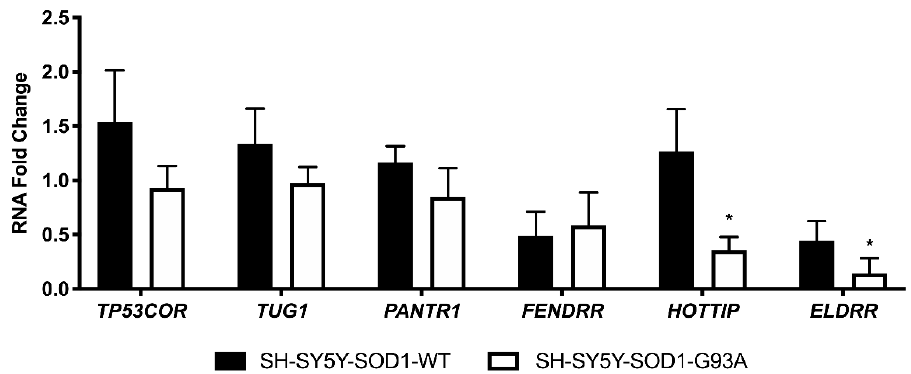
Figure 9. Analysis of human homologues of investigated lncRNAs. RNAs expression levels were evaluated by Real Time-PCR in triplicates in 3 independent experiments ( n = 9). Data are expressed as mean ± SEM. * p < 0.05 vs. SH-SY5Y-SOD1-WT.